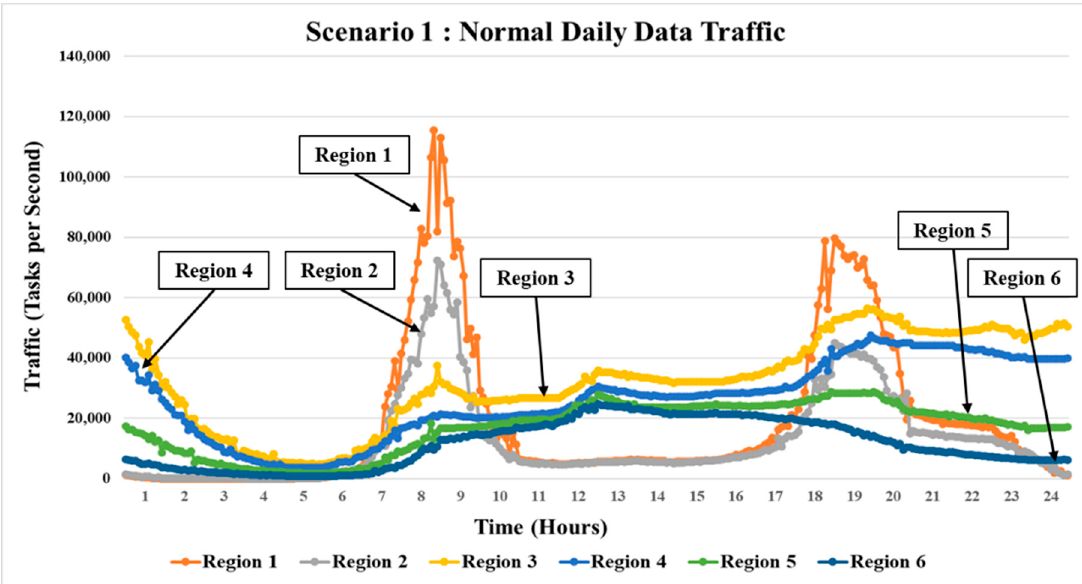
Figure 7. Twenty-four hour data traffic patterns for Scenario 1: normal daily traffic conditions.